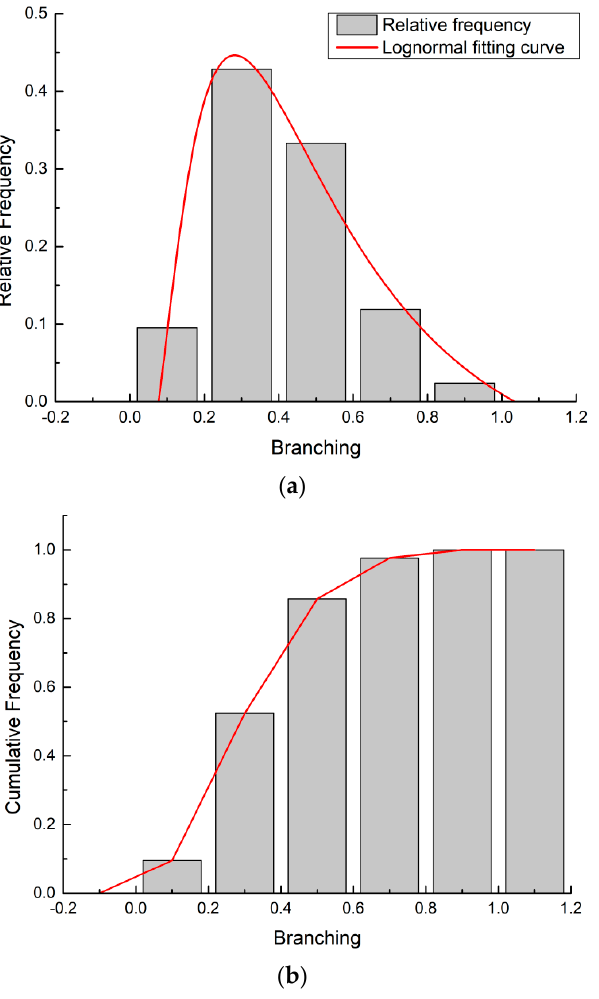
Figure 8. Branching frequency histogram of newly produced microcracks. ( a ) Relative frequency. ( b ) Cumulative frequency.